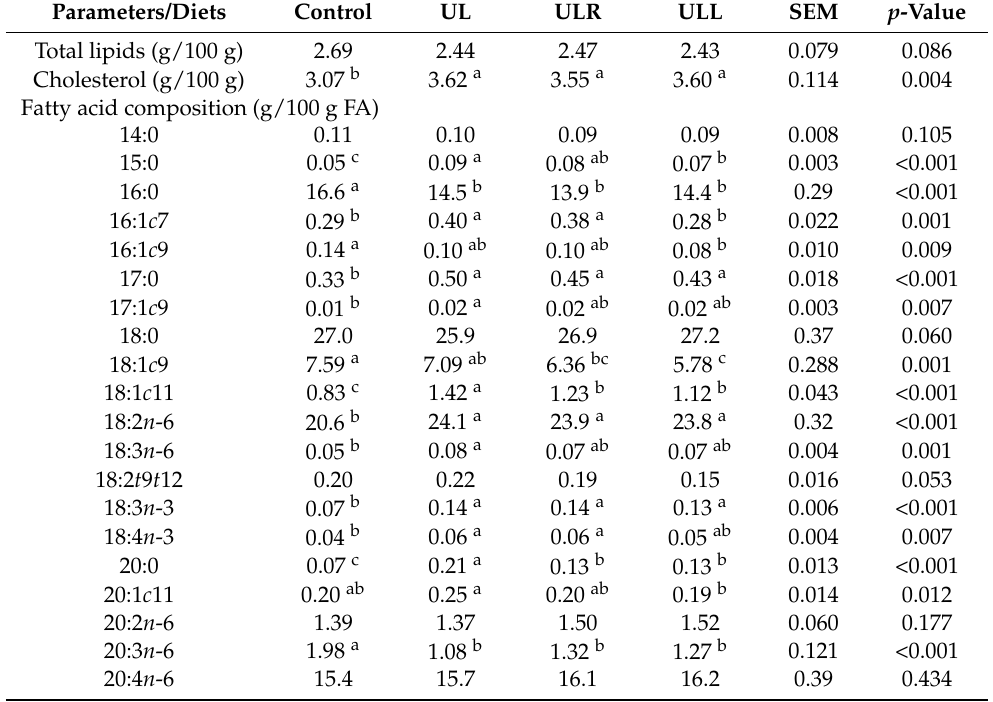
Table 3. Hepatic total lipids and cholesterol contents and fatty acid composition of broilers as affected by diets ( n =